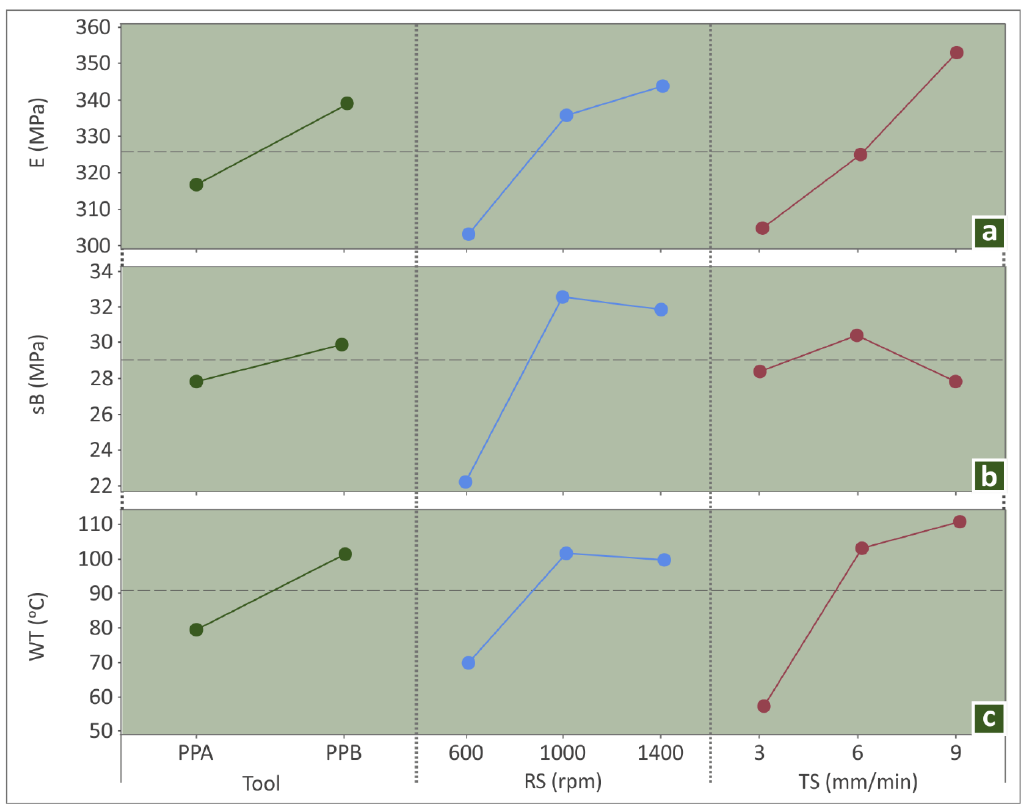
Figure 11. MEP plots: ( a ) E, ( b ) sB, and ( c ) WT. The interaction plots were adopted to see inside the processing conditions and how each parameter interacts with each other (see Figures 12 – 14).